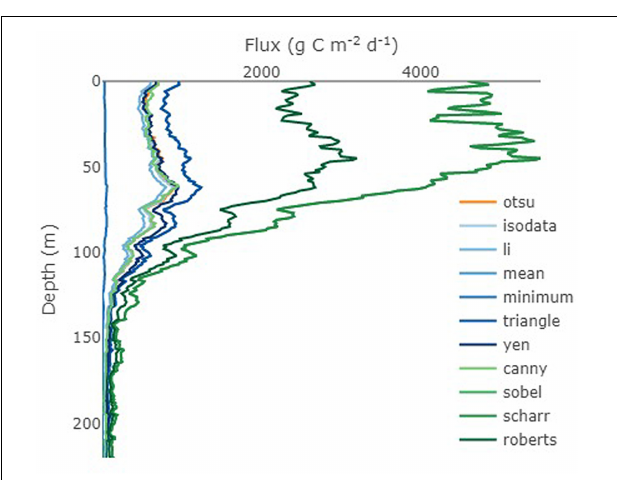
FIGURE 7 | Flux profiles from deployment DY086-34 near South Georgia according to the different threshold algorithms. Fluxes were calculated for all particles as described in the methods and summed for each vignette. Flux profiles were binned at 1-m resolution and a running mean ( n = 11) calculated.